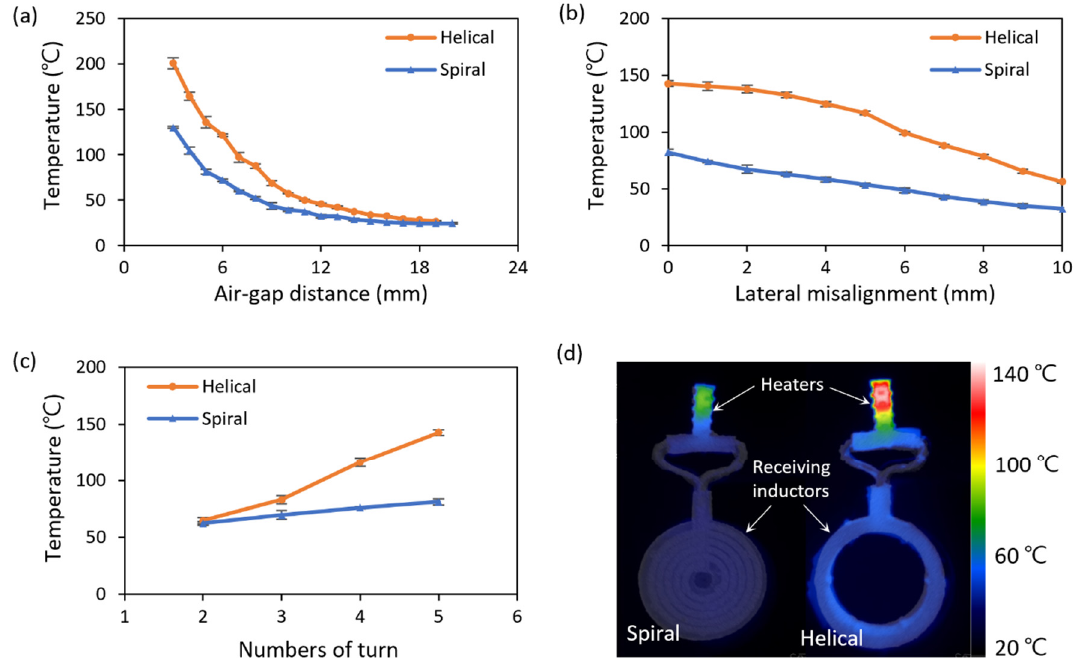
Figure 6. Characteristics of the heater connected to the two-dimensional spiral and the three-dimensional helical inductor: Temperature change of the heaters ( a ) according to the air-gap distance between the transmitting inductor and the receiving inductor, ( b ) along the misaligned distance, and ( c ) according to winding numbers of the heaters. ( d ) Temperature distribution of the heaters and the receiving inductors, captured by an infrared camera.